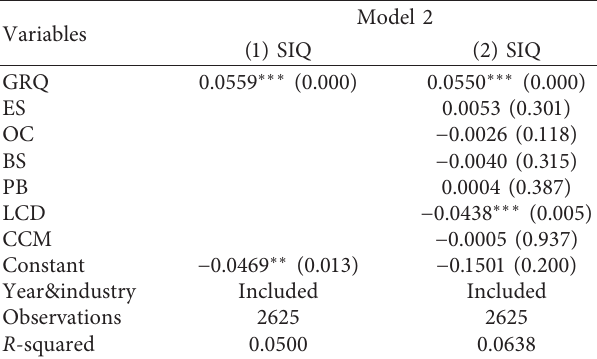
Table 5: Regression results of Hypothesis 2.